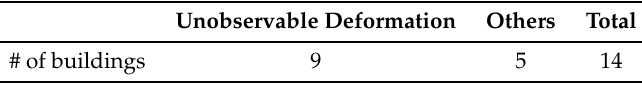
Table 4. The reasons for underestimations.